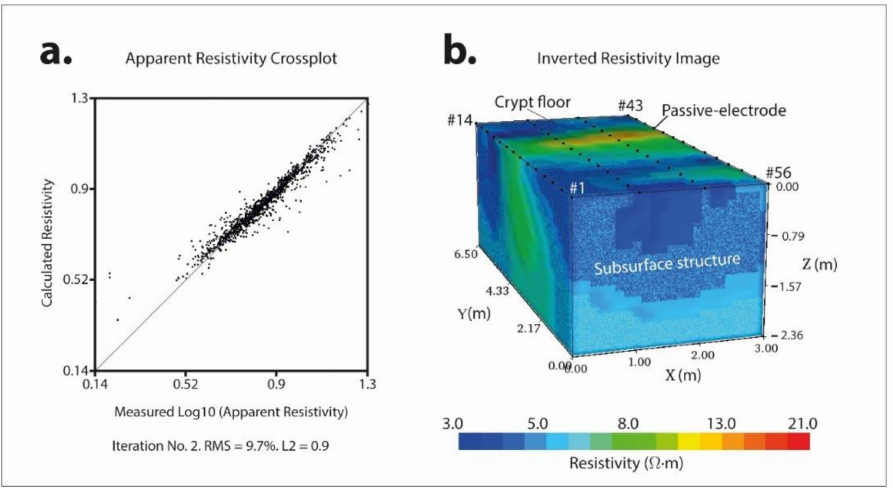
Figure 6. ( a ) Calculated apparent resistivity vs. measured apparent resistivity cross plot, ( b )